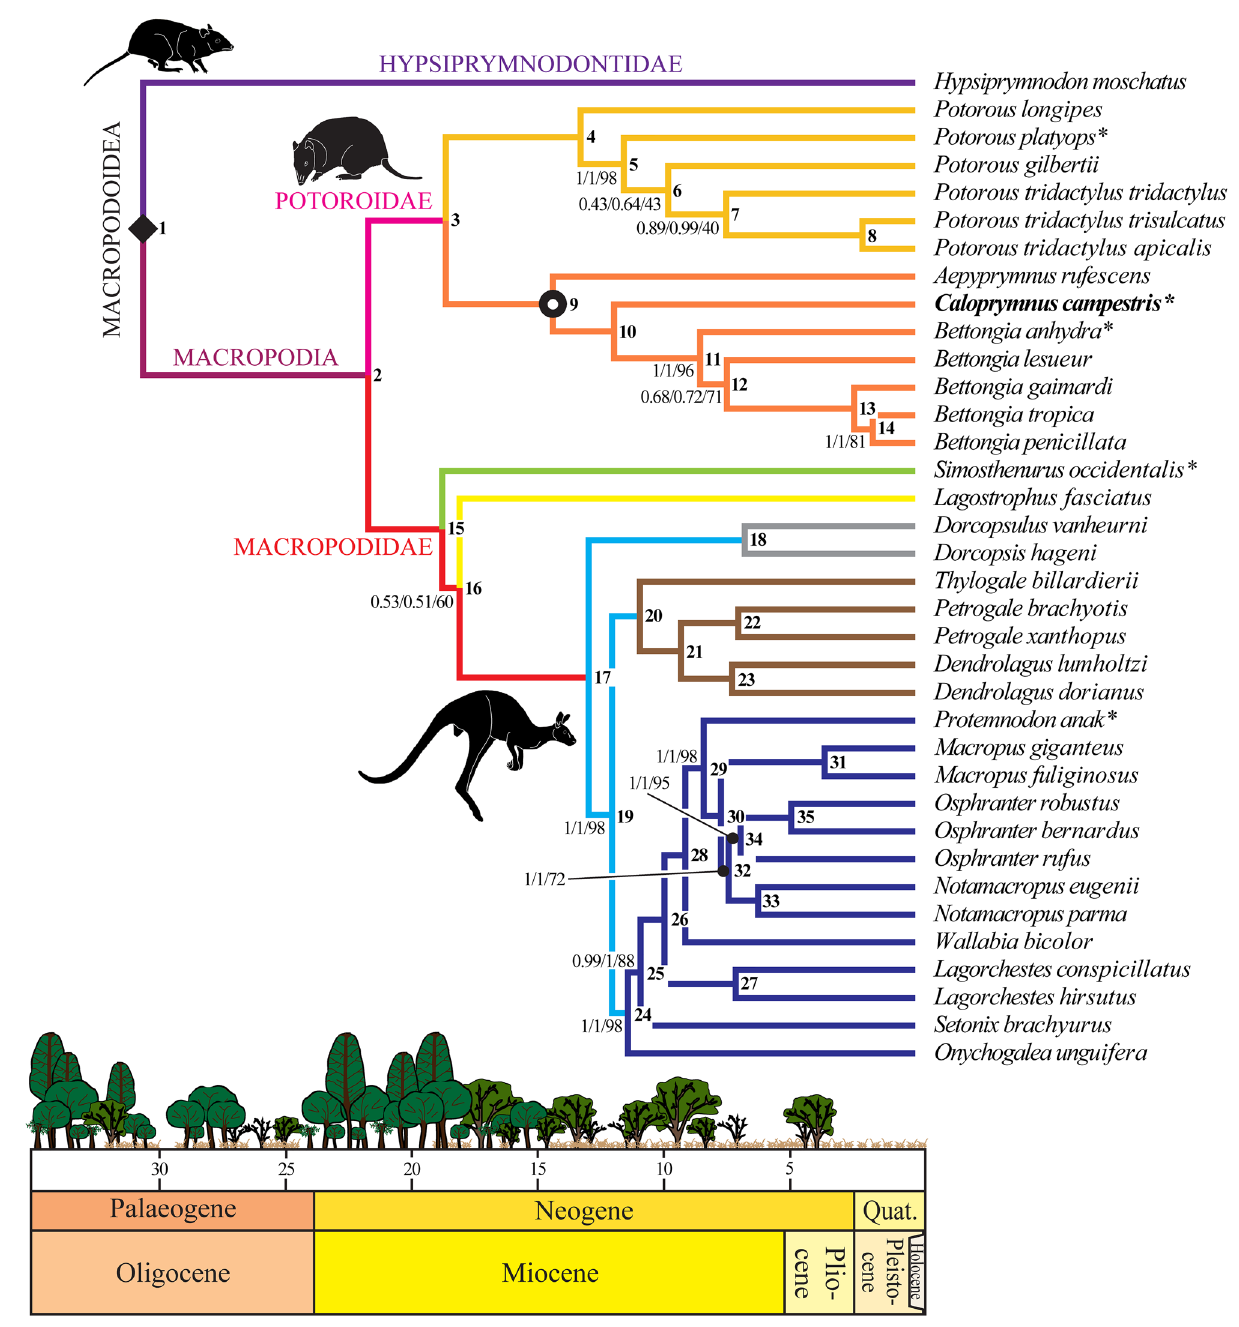
Figure 2. Time calibrated phylogeny of crown Macropodoidea (filled black diamond) showing divergence of Caloprymnus campestris (bold type) within Bettonginae (black open circle), and correlated against a schematic of changing palaeohabitats across the late Oligocene–Holocene interval (modified from Kear et al. 6 and Den Boer et al. 82 ). Topology is based on the partitioned mitogenome/mtDNA/nDNA dataset. Bayesian posterior probability (< 1.0) and bootstrap (< 100%) support values (regular type) derived using BEAST 2.2.1 36 /MrBayes 3.2.7 35 /RAxML 7.2.8 34 are indicated at relevant nodes. Branch colours denote major clades: Hypsiprymnodontidae (purple); Macropodia, new clade (burgundy); Potoroidae (pink); Potoroinae (orange); Bettonginae (ochre); Macropodidae (red); Sthenurinae (green); Lagostrophinae (yellow); Macropodinae (light blue); Dorcopsini (grey) Dendrolagini (brown); Macropodini (dark blue). *Extinct taxa. See Table 2 for node number references (bold type) and the Supplementary Information for other analyses. Graphics produced with Adobe CC2021 by